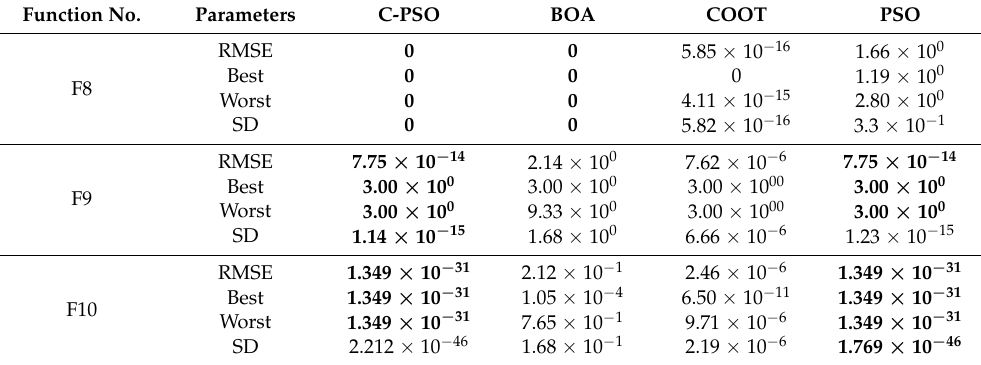
Table 1. Cont. Function